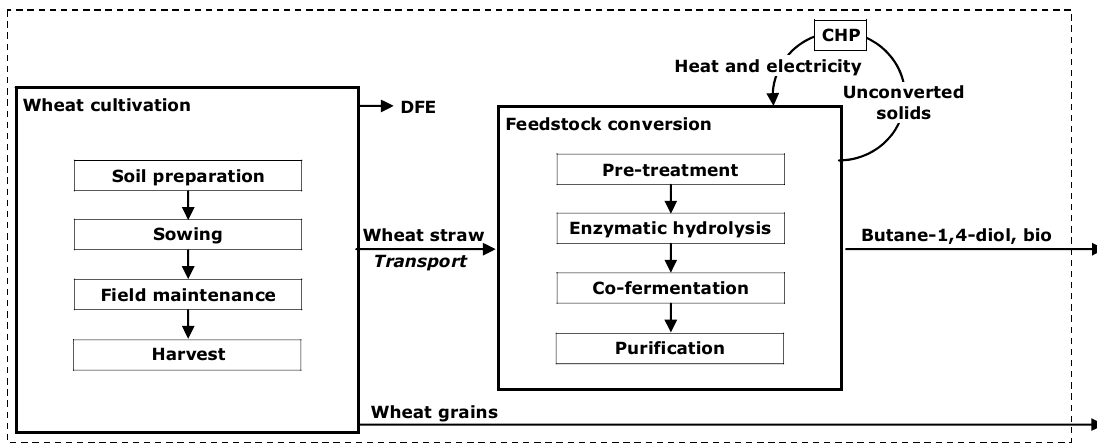
Figure 1. Analyzed production stages of bio-based BDO production chain. The dotted frame shows the “cradle-to-factory gate” system boundary investigated in the study.